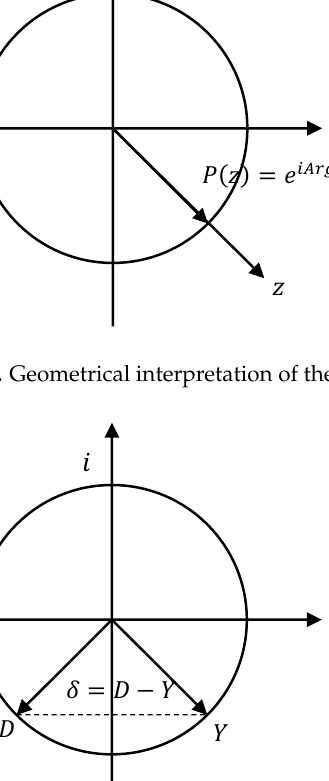
Figure 2. Geometrical interpretation of the continuous MVN activation function.